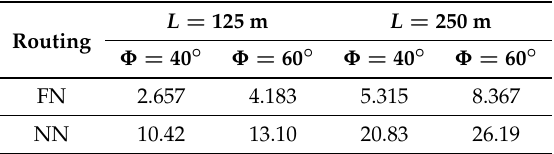
Table 2. Blockage-free end-to-end (EE) hop count η